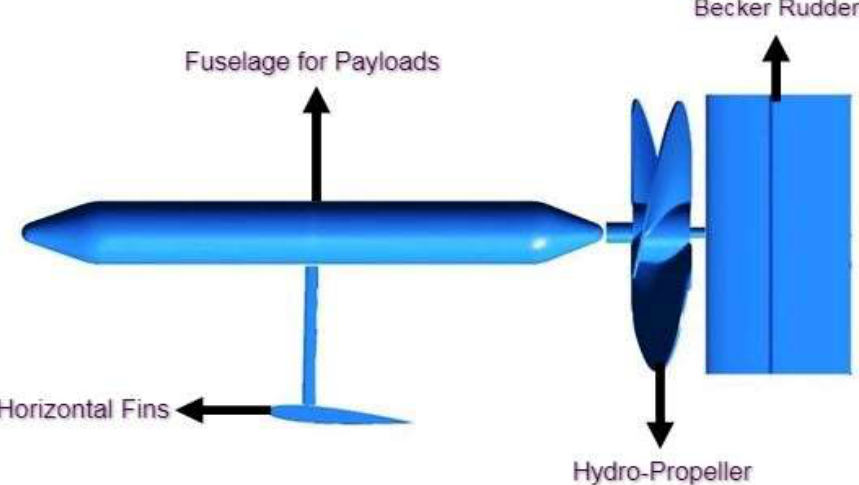
Figure 9. A typical side view of US attached with advanced horizontal fins.